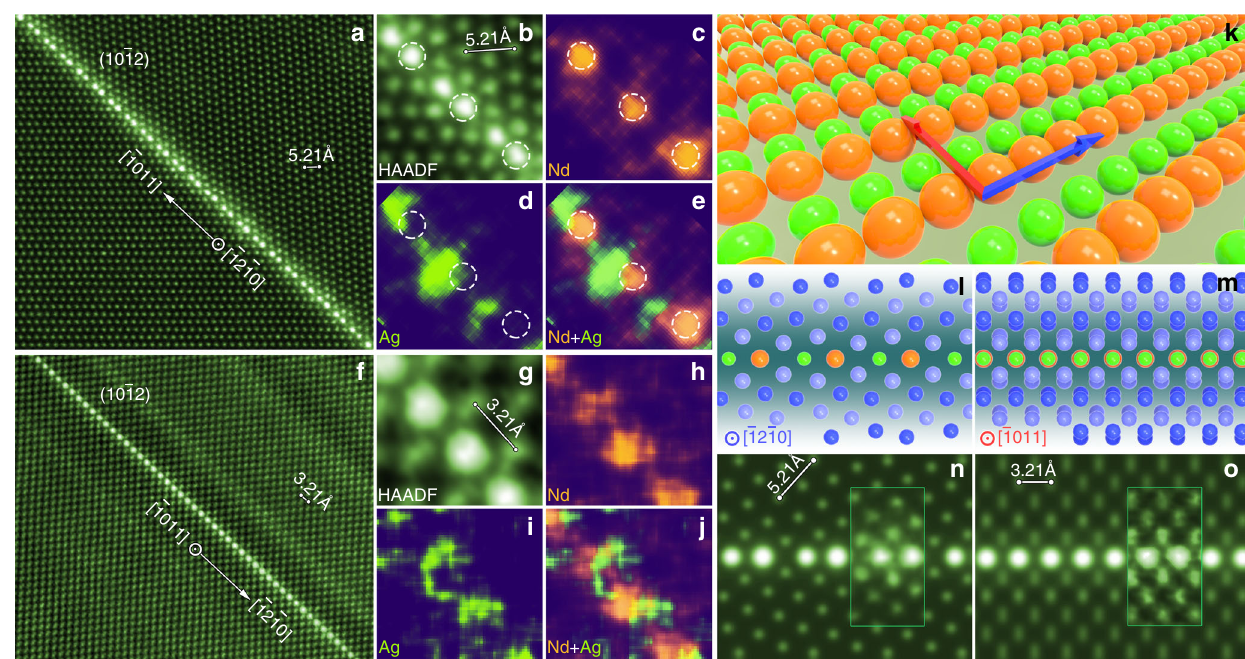
Fig. 1 Alternating distribution of Nd and Ag columns in a 10 (cid:1) 12 ð Þ twin boundary. a Atomic-resolution (cid:1) 12 (cid:1) 10 ½ (cid:2) HAADF-STEM image. b Enlargement of a region in a . c – e Corresponding atomic-resolution EDS maps showing atomic columns rich in c Nd, d Ag and e (Nd + Ag). Dashed circles in ( b – e ) indicate extension sites. f Atomic-resolution (cid:1) 1011